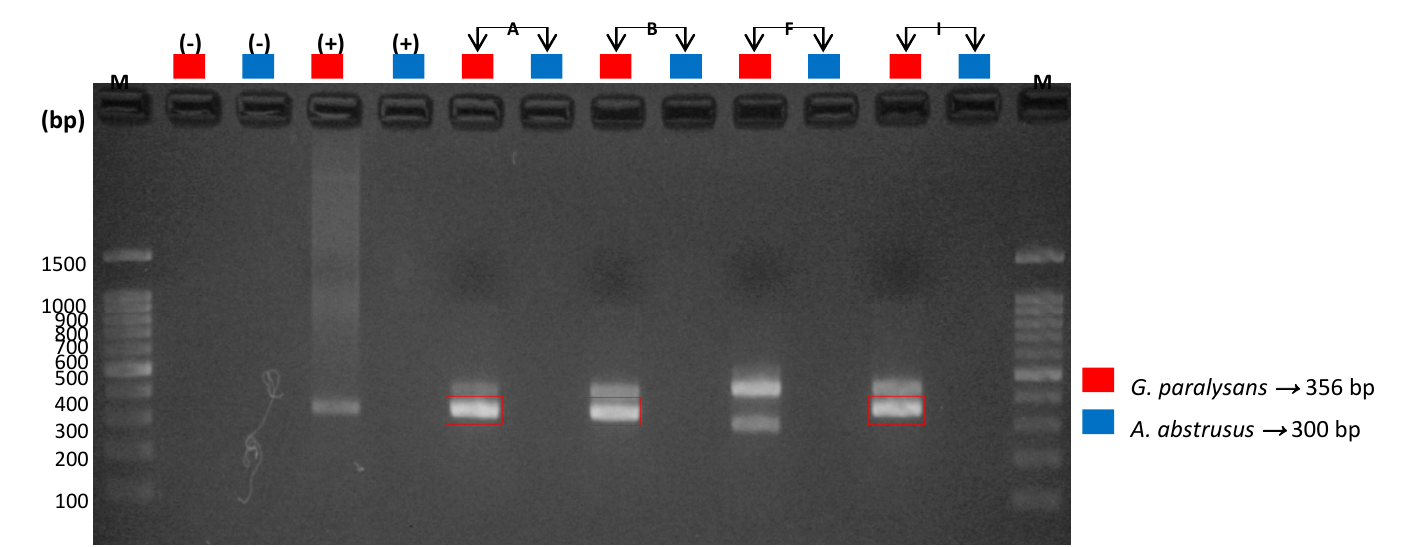
Figure 4. Molecular detection of G. paralysans and A. abstrusus by semi-nested PCR in samples of cerebrospinal fluid (CSF) from domestic cats. M: Molecular weight marker; ( − ): Negative control; ( + ): Positive control; bp: base pairs; A, B, F and I: domestic cats analysed in this